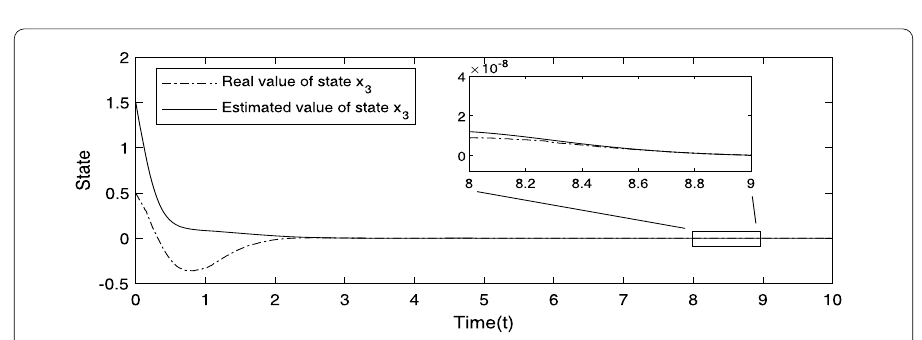
Figure 7 The simulation for state x 3 of the closed-loop systems with uncertainties